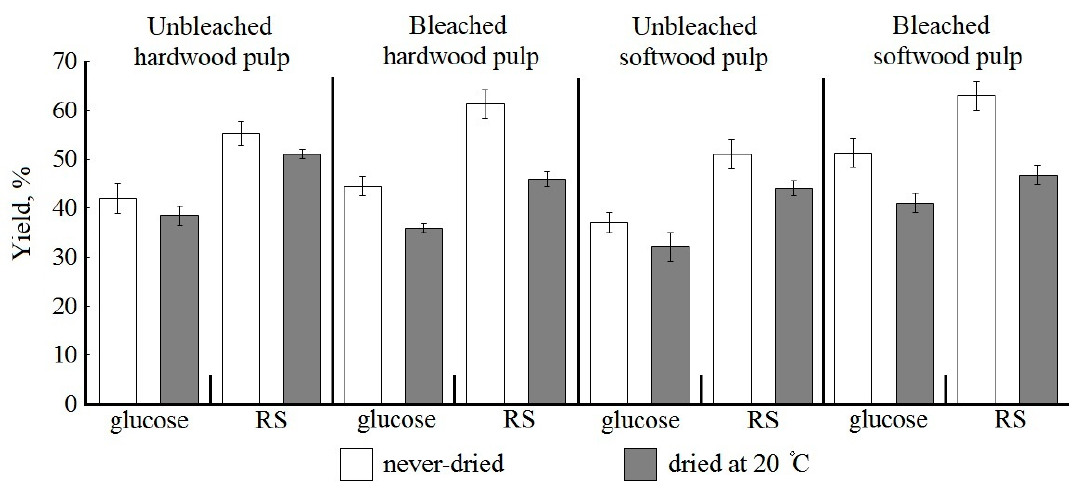
Figure 1. E ff ect of lignin and drying on bioconversion of kraft Figure 1. Effect of lignin and drying on bioconversion of kraft pulp.